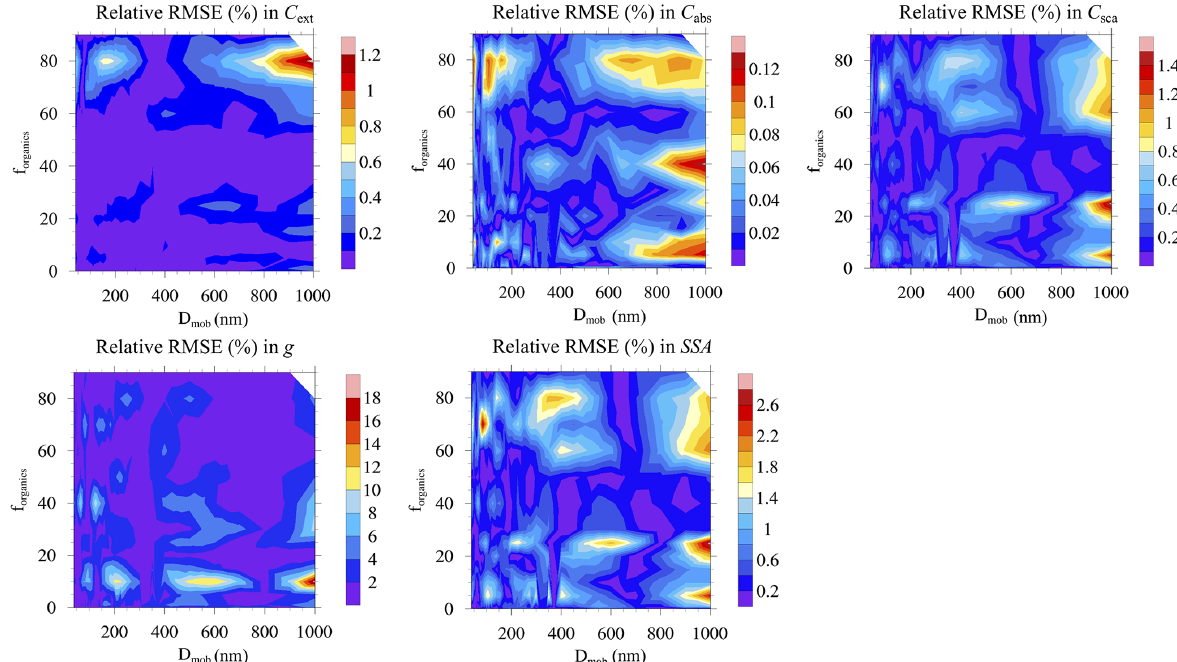
Figure 15. The relative RMSE between MSTM-modelled and parameterized values of C ext , C abs , C sca , g , and SSA for various cases of fraction of organics ( f organics ) at λ = 660nm. The fractal dimension ( D f ) is fixed to